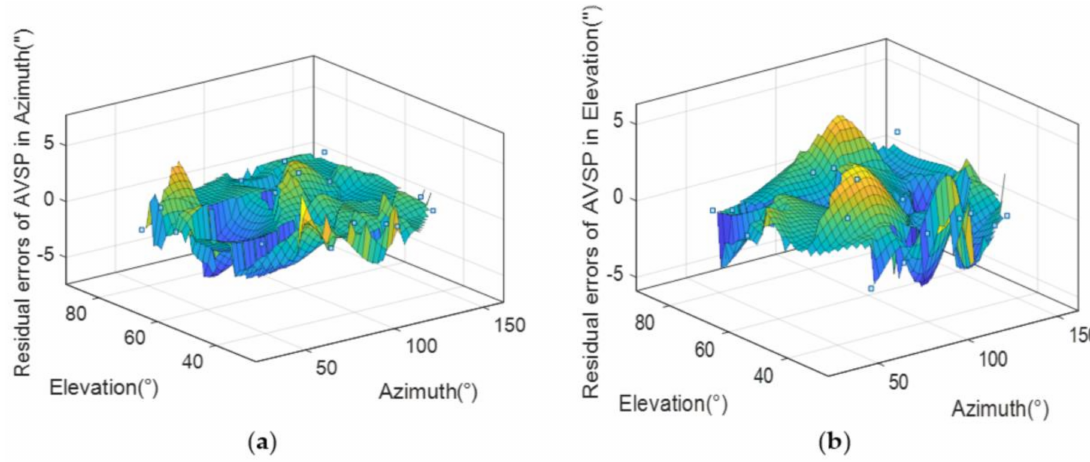
Figure 6. Residual errors and fitting surface of AVSPM: ( a ) in azimuth; and ( b ) in